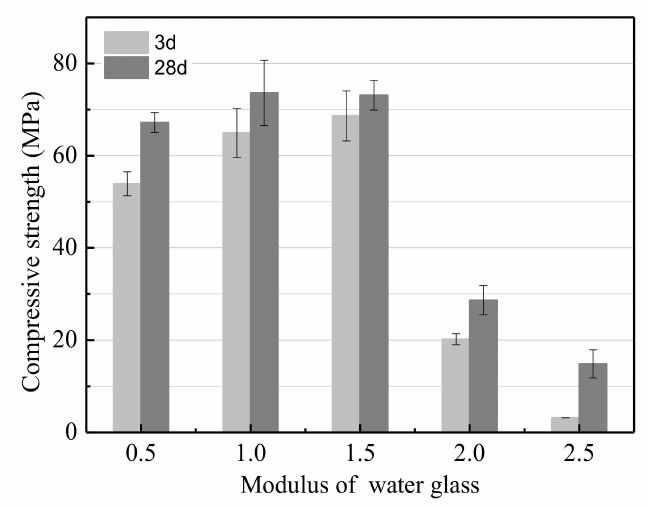
Figure 2. The e ff ect of the modulus of water glass on the unconfined compressive strength (UCS).